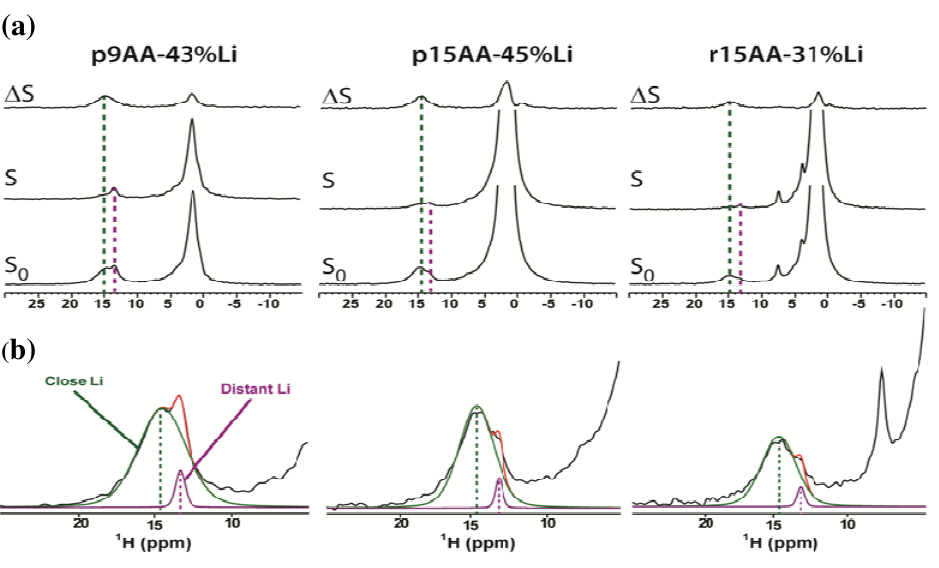
Figure 1. ( a ) The solid-state 1 H MAS REDOR NMR of the partially Li-neutralized precise and pseudo-random P(E-AA) ionomers for τ = 1.8 ms. The reference spectra are REDOR denoted by S , the 1 H- 7 Li-dipolar coupled dephased spectra are labeled S , and the 0 differences spectra by ∆ S ; ( b ) The carboxylic acid spectral expansion of the reference spectra showing deconvolutions into two different environments corresponding to a “close” and “distant” 1 H- 7 Li